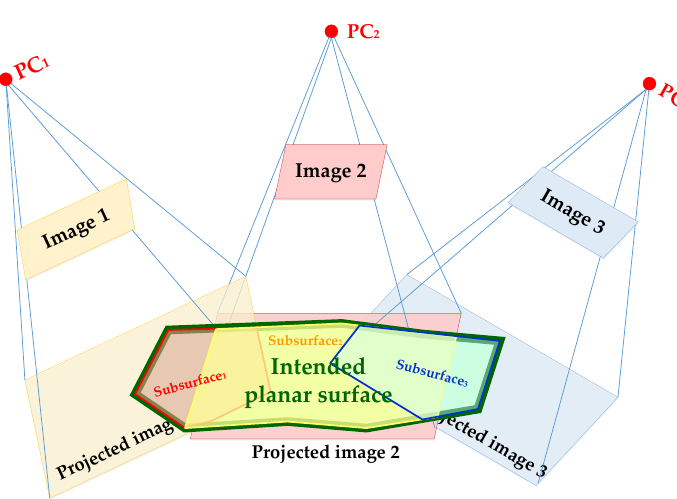
Figure 14. A partially-visible planar surface within multiple overlapping images.